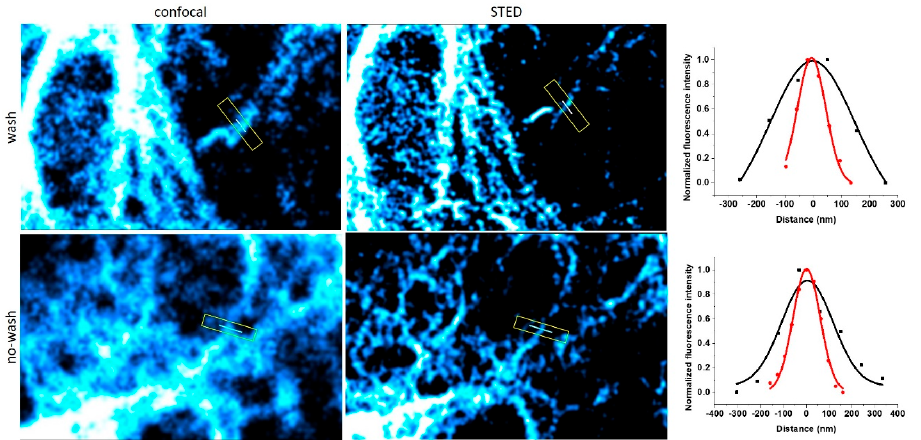
Figure 3. Confocal and STED microscopy images of Vim Lys- BCN -mOrange expressing COS-7 cells labeled with 8 ( λ exc : 488 nm, CW 660 nm depletion laser). Full-width at half maximum (FWHM) values for confocal (black) and STED images (red) were 351 ± 95 and 118 ± 10 nm for washed and 264 ± 60 and 140 ± 8 nm for no-washed samples, respectively.